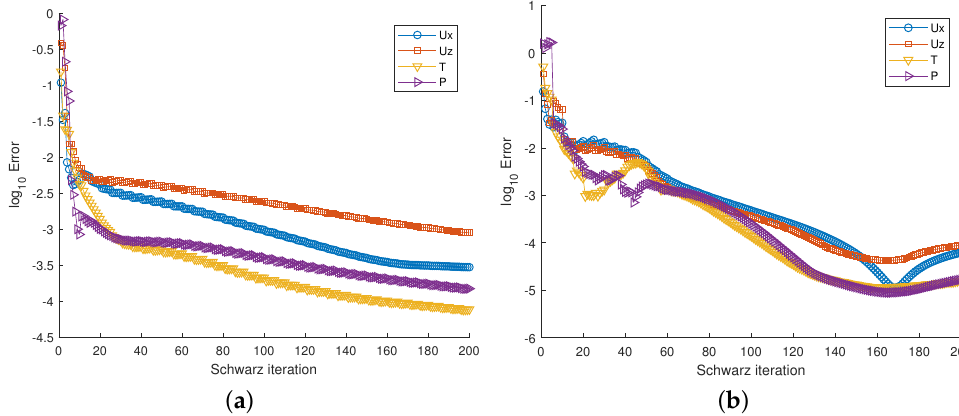
Figure 14. Graph of the log 10 of the errors in the velocity, temperature, and pressure fields for the Schwarz iterations: ( a ) R = 10 4 , Γ = 3.495, np = 25, mp = 2, N × M = 12 × 10; ( b ) R = 10 5 , Γ = 3.495, np = 25, mp = 5, N × M = 16 × 12.